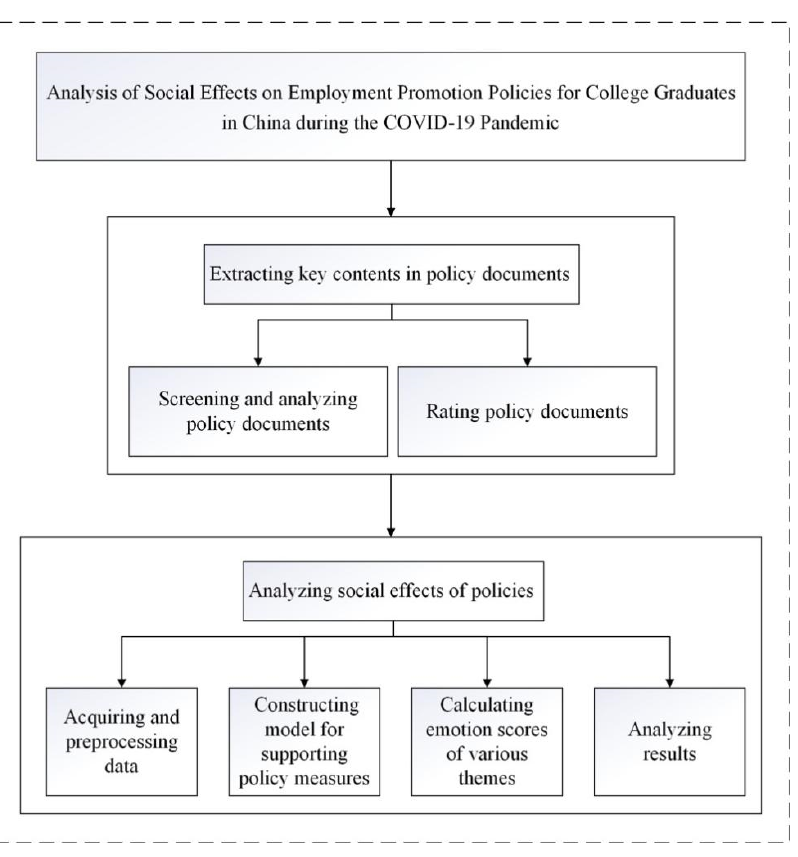
Figure 1. Research